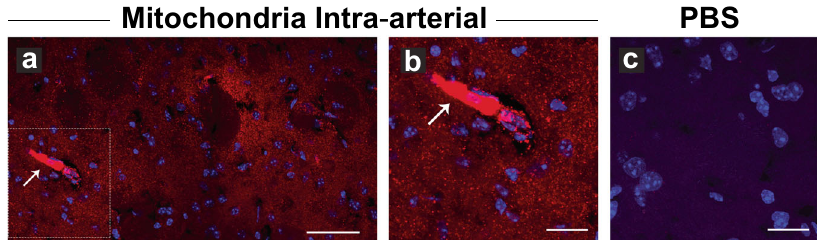
Fig. 3 Intra-arterial injection can deliver mitochondria in the ischemic brain parenchyma. Mice were stroked with middle cerebral artery occlusion, injected intraarterially and their brains were cryo-sectioned and stained with DAPI (blue). a and b Stroked brain injected with exogenous mitochondria pre-labeled with MitoTracker (red), c Stroked brain injected with PBS. Both animals were injected in the common carotid artery following middle cerebral artery occlusion. Images were acquired in the striatum with confocal microscopy. Mitochondria crossed the blood – brain barrier and localized throughout the parenchyma. Occasionally, mitochondria were found deposited in the blood vessels (white arrow). b Higher magni fi cation of a mitochondrial deposit shown in a . a Scale bar, 50 μ m. b , c Scale bar, 25 μ